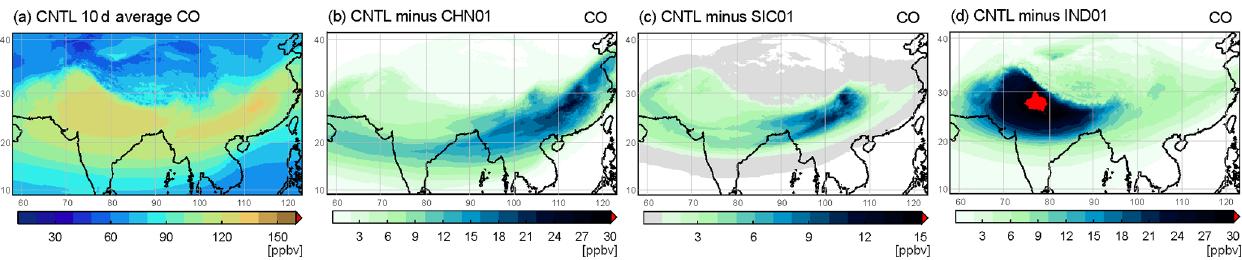
Figure 12. 10d averaged chemical components of CO concentration (ppbv) at the altitude of 14.8km from 1 to 10 August 2017 produced by (a) CNTL, (b) CNTL minus CHN01, (c) CNTL minus SIC01, and (d) CNTL minus